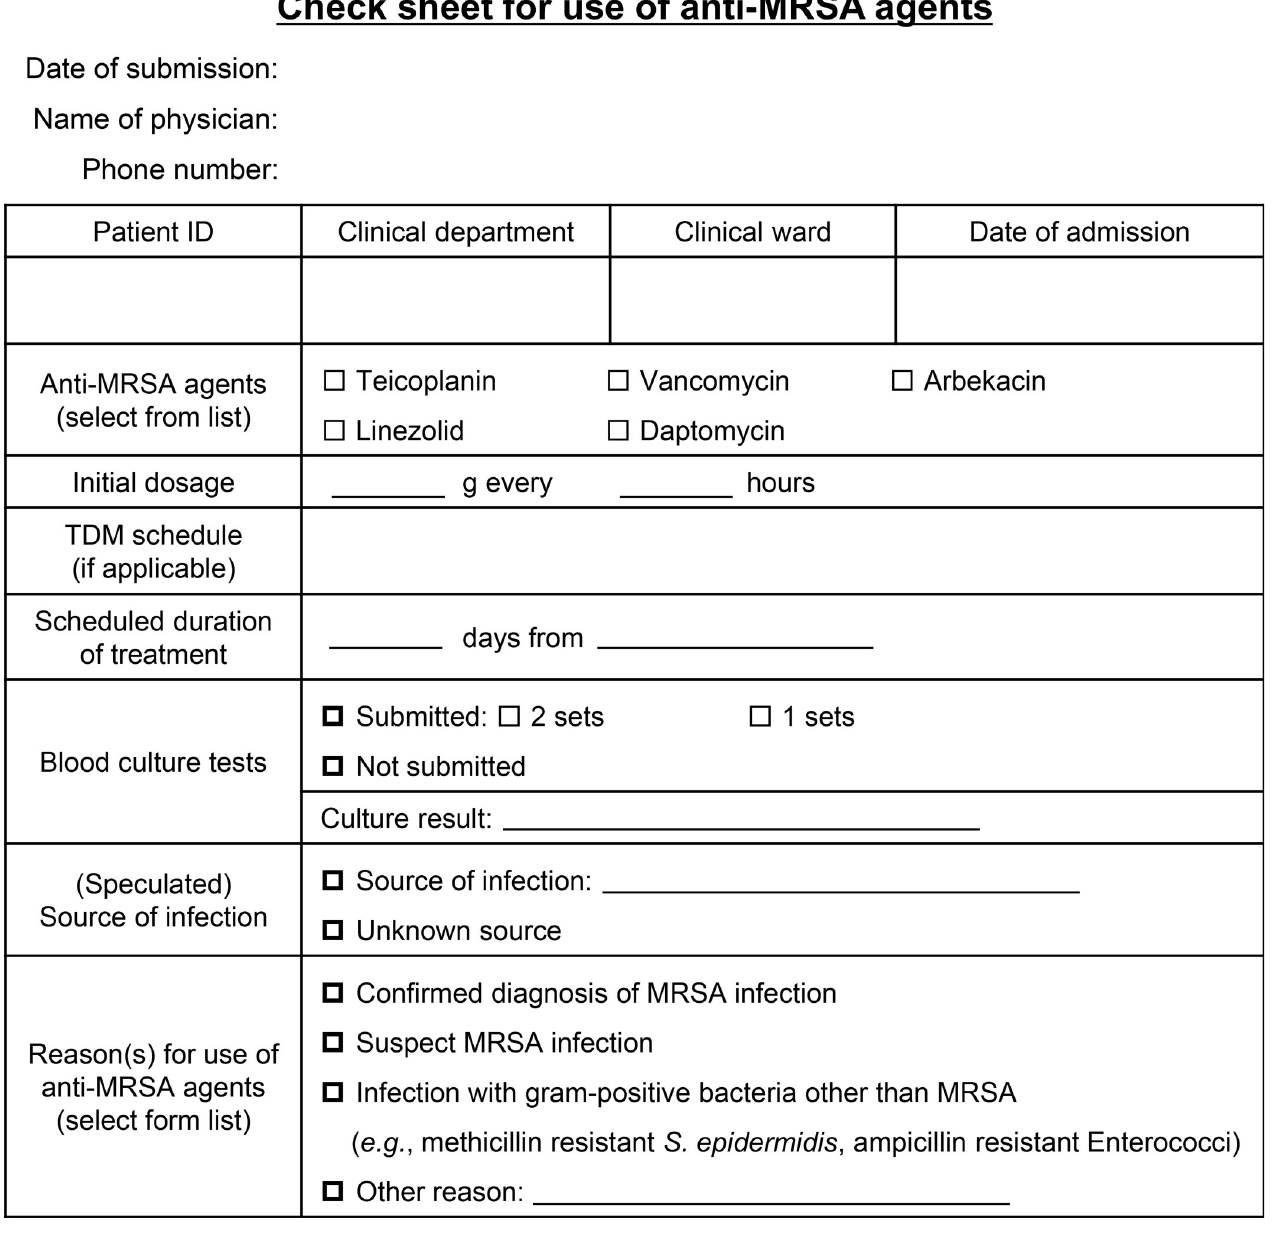
Fig 1. Check sheet for the use of anti-MRSA agents (English translation). infection (CSI), catheter-related blood stream infection (CRBSI), febrile neutropenia (FN), intraabdominal infection (IAI), urinary tract infection (UTI), respiratory tract infection (RTI), surgical site infection (SSI), skin and soft-tissue infection/bone and joint infection (SSTI/BJI), and other infections. The primary outcome was time to de-escalation. Secondary outcomes were hospital-wide consumption of anti-MRSA agents, in-hospital mortality, 30-day mortality, length of stay in hospital (LOSH), duration of anti-MRSA agent therapy, reasons for discontinuation, incidence